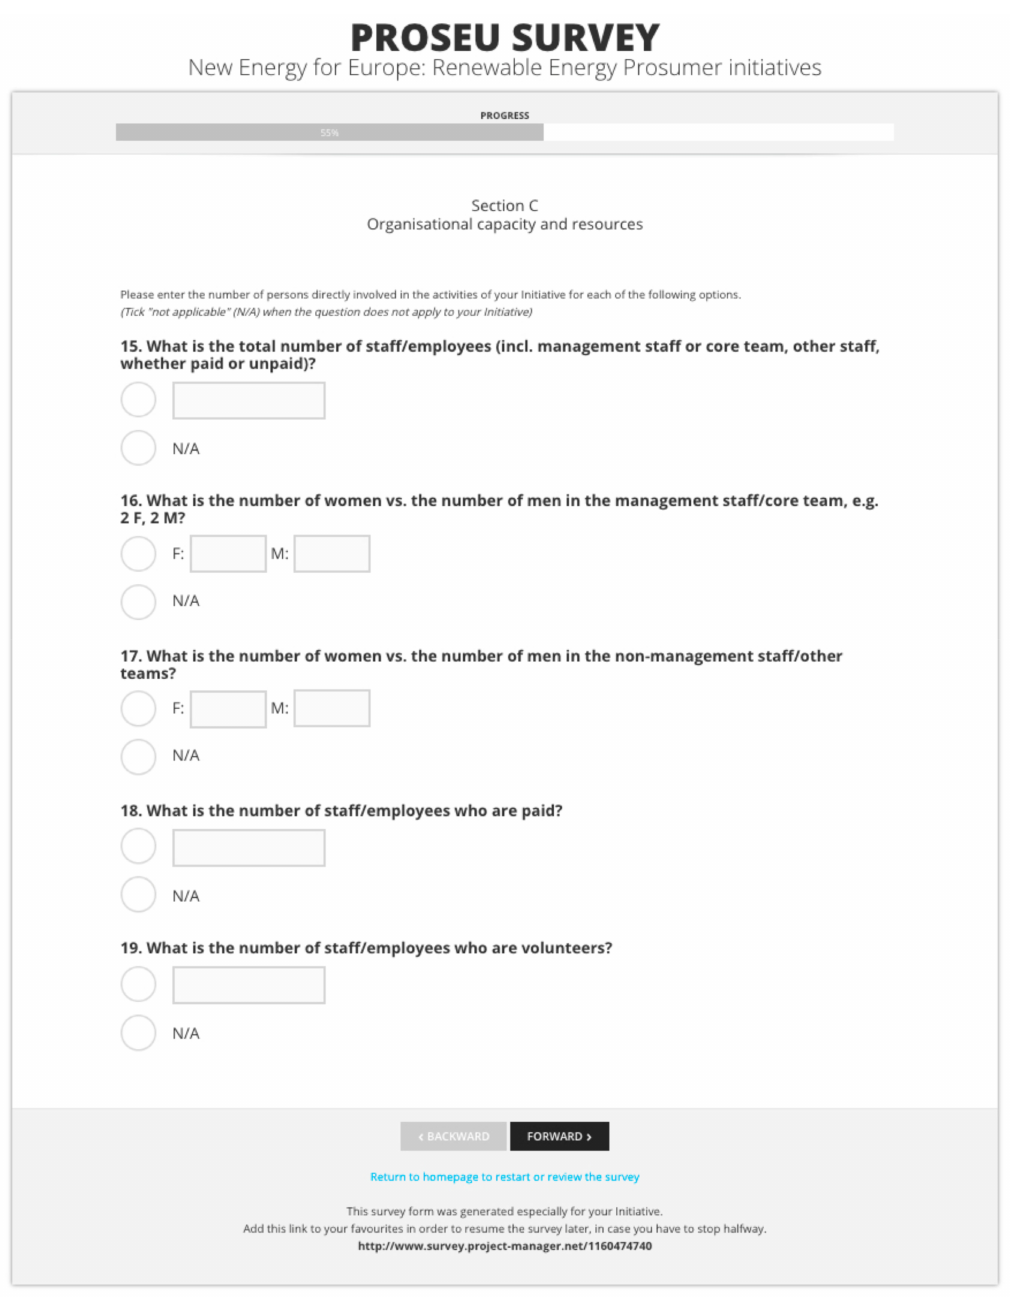
Figure A3. Questions 15–19 of the survey